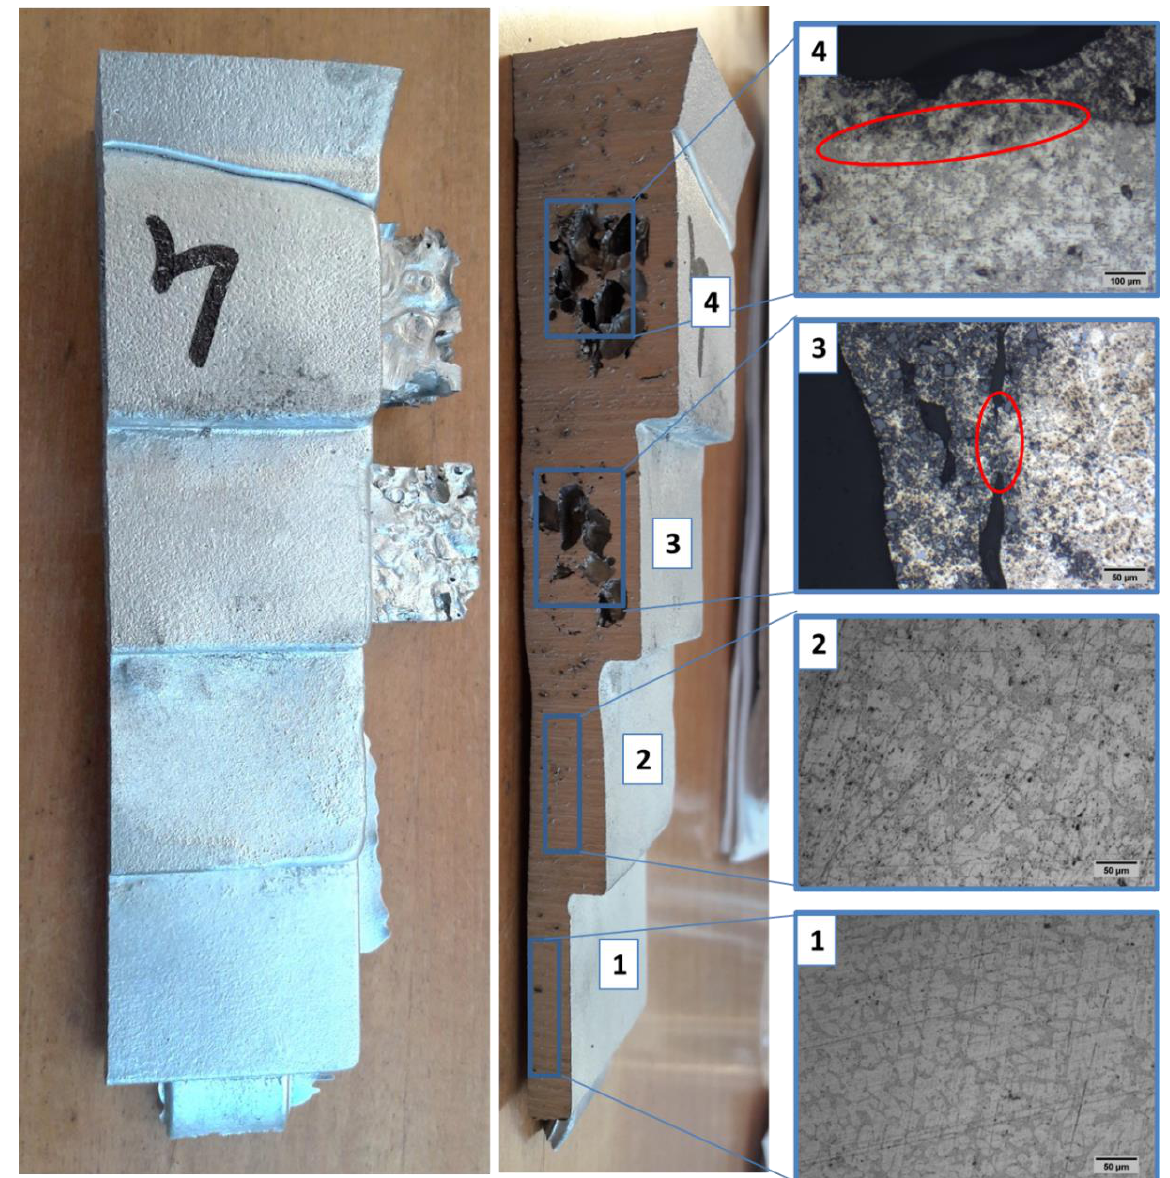
Figure 9. Foam 3 inserted in cast object, visual appearance of the cast object (top surface and cross section), and optical microscopy on the cross section. 1 – 4 optical images of the different steps of the cast object